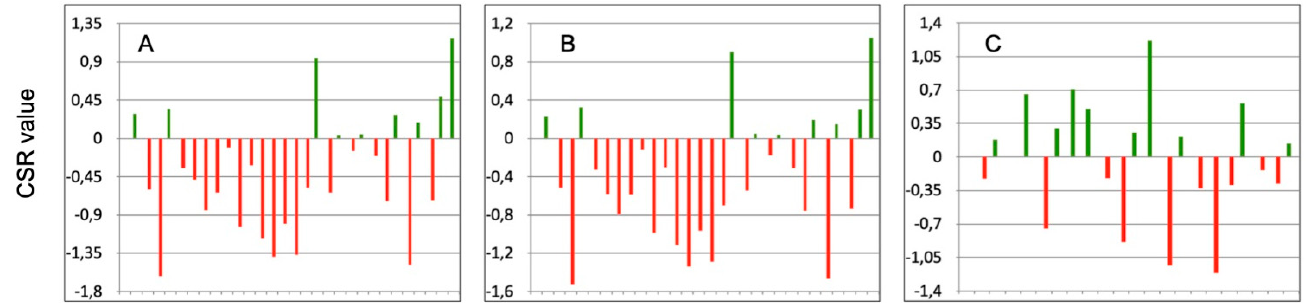
Figure 2. The values of CSR A-M ( A ), CSR A-H ( B ), and CSR M-H ( C ) when comparing athletes after ACL reconstruction to both the MI and C groups. Zero represents the group average CSR value; green bars indicate positive value (it means that the particular athlete is better than average); red bars indicate negative value (it means that the particular athlete is worse than average).